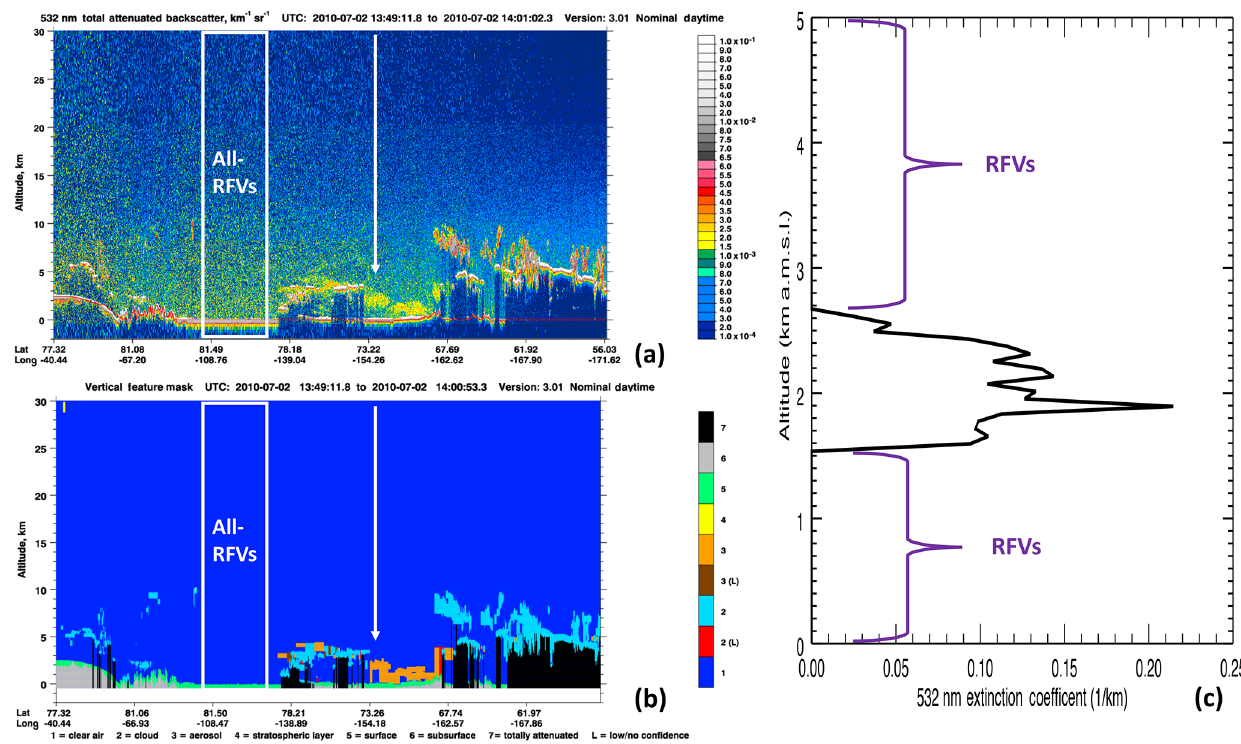
Figure 1. For data collected during the daytime on 2 July 2010 over the Arctic, browse image curtain plots of CALIPSO (a) 532nm total attenuated backscatter (km − 1 sr − 1 ) and (b) corresponding vertical feature mask (VFM). The white box represents an example segment of the granule for which range bins in the associated level 2 (L2) aerosol extinction coefficient profile are all retrieval fill values (RFVs), as the VFM classified these bins as either surface (green) or clear-air (blue) features. The white arrow indicates a column in which some aerosol has been detected (orange), and the resultant L2 aerosol extinction profile for this column is shown in (c)